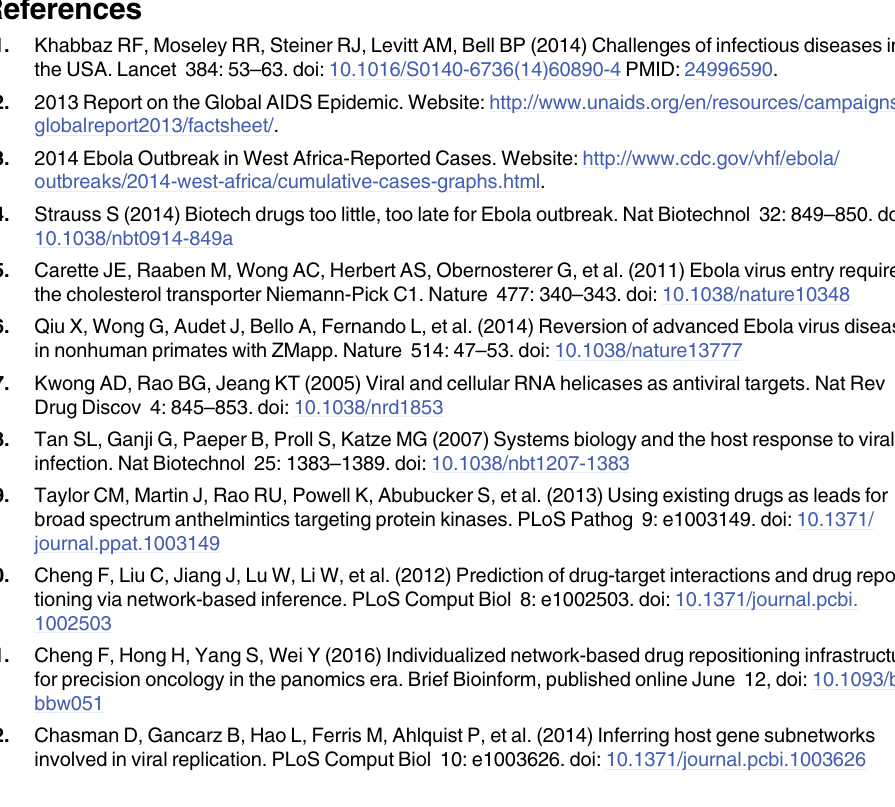
S7 Table. List of existing drugs targeting 691 virus target genes identified by gene-trap studies and previously reported RNAi screens. S8 Table. Details of computationally predicted antiviral indications for existing drugs. S9 Table. Anti-HIV activities of top 20 predicted candidates based on the evidence from the